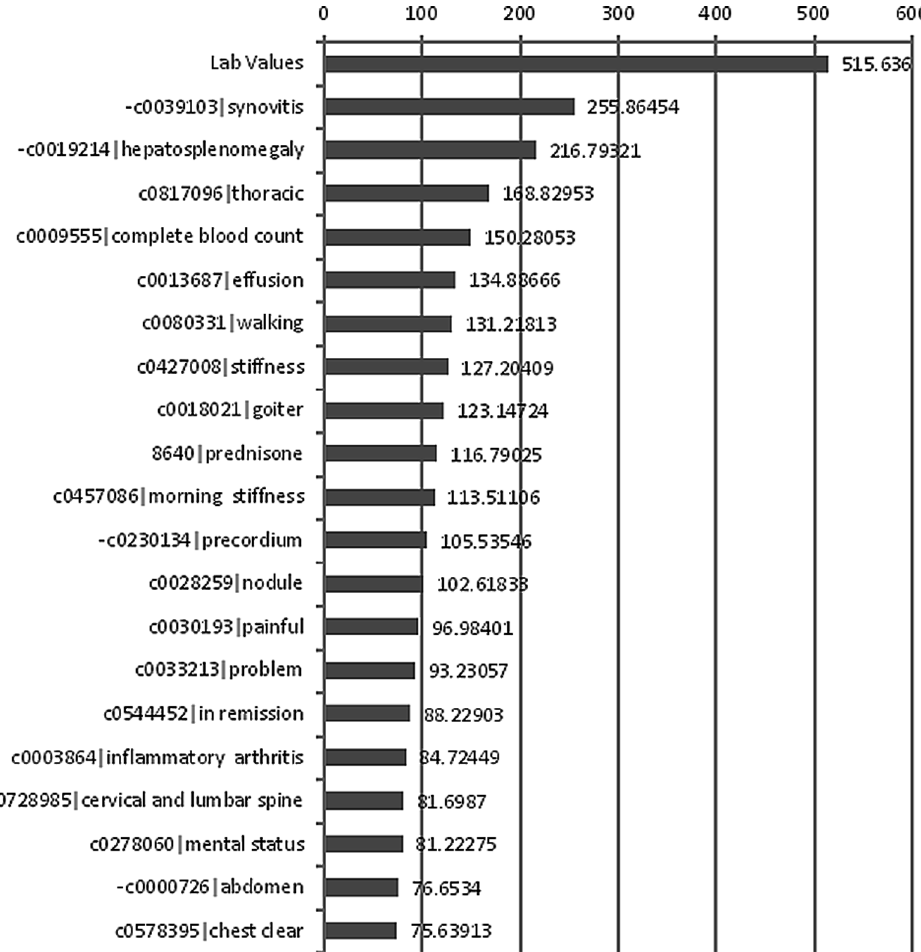
Figure 2. Lab-value and 20 top-ranked CUIs. Their Chi-square values were visualized as bars. Longer bars suggest higher impact. The negative signs ‘‘-’’ before some of the CUIs suggest negation (CUI – Unified Medical Language System Concept Unique Identifier).